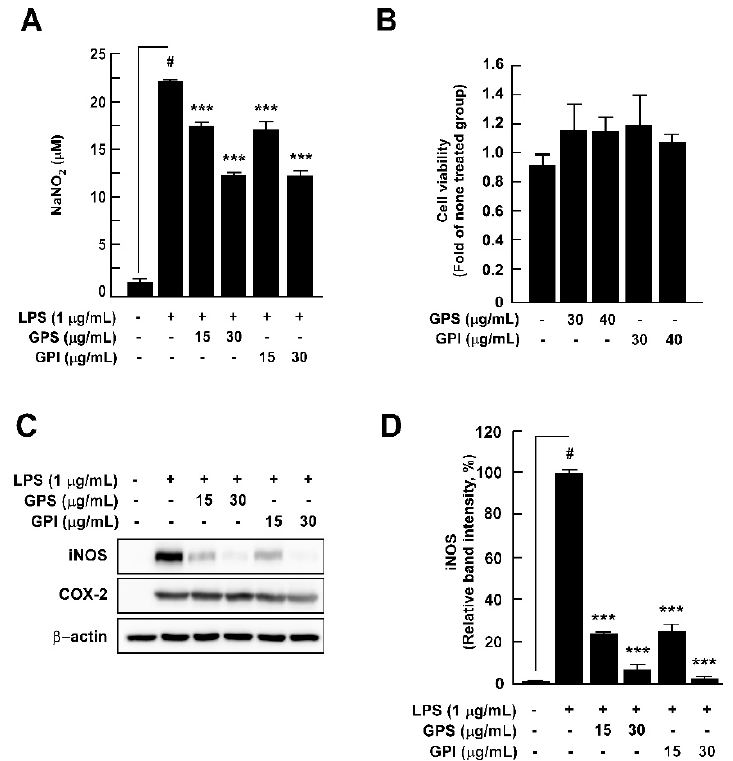
Figure 2. Effects of GPEs on LPS-induced nitrite production, cell viability, and phosphorylation of MAPKs and p65 in RAW 264.7 cells. (A) GPE suppressed the LPS-induced nitrite production in RAW 264.7 cells. Cells were pretreated with GPE in the presence or absence of LPS (1 μ g/mL) for 24 h. (B) GPEs did not affect the cell viability at the tested concentrations. The cells were treated with increasing concentration of GPE for 24 h. (C) GPEs suppressed the LPS-induced iNOS and COX-2 expression in RAW 264.7 cells. (D) Quantification of iNOS suppression by GPEs. Expression levels of iNOS, COX- 2, and β -actin were determined by western blot. Data are presented as mean ± SD of three independent experiments. # p < 0.05 between control and LPS-exposed cells (no GPE); * p < 0.05; ** p < 0.01.